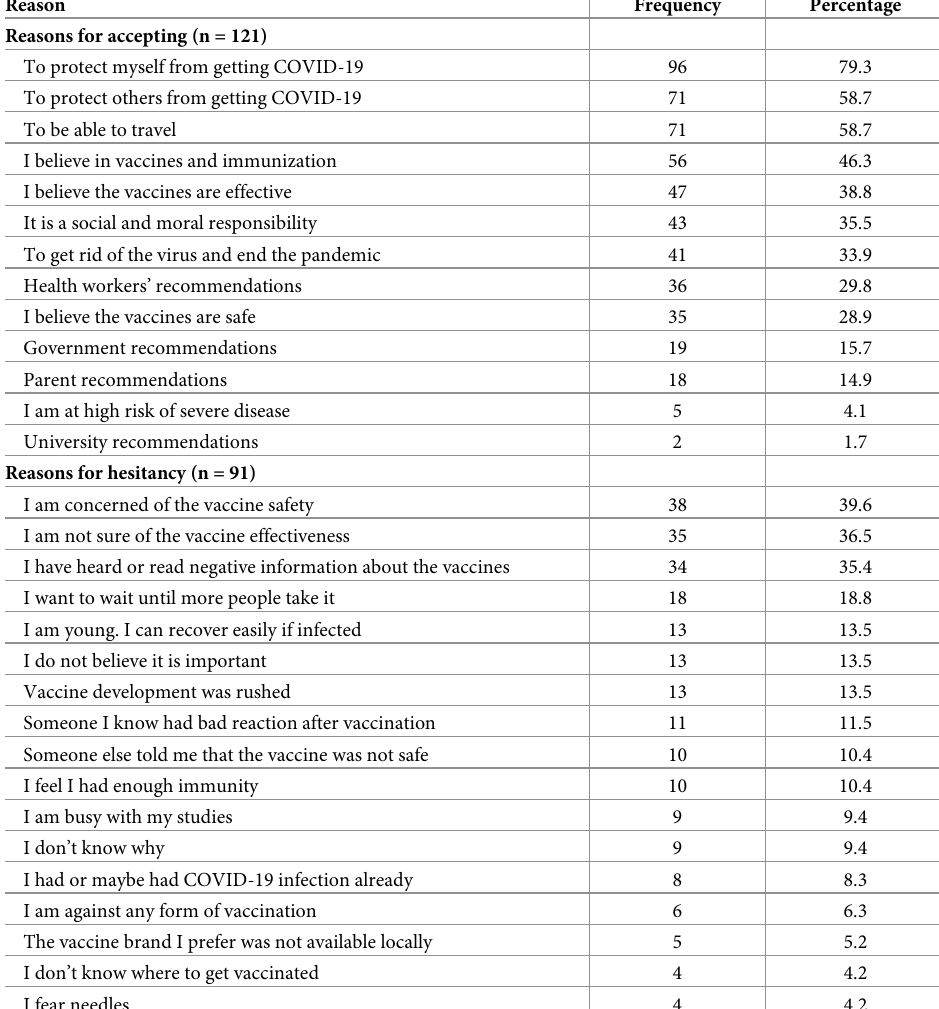
Table 2. Reasons for acceptance and hesitancy of the COVID-19 vaccine among medical students at IUA, Khar- toum, Sudan, 2021 (n =